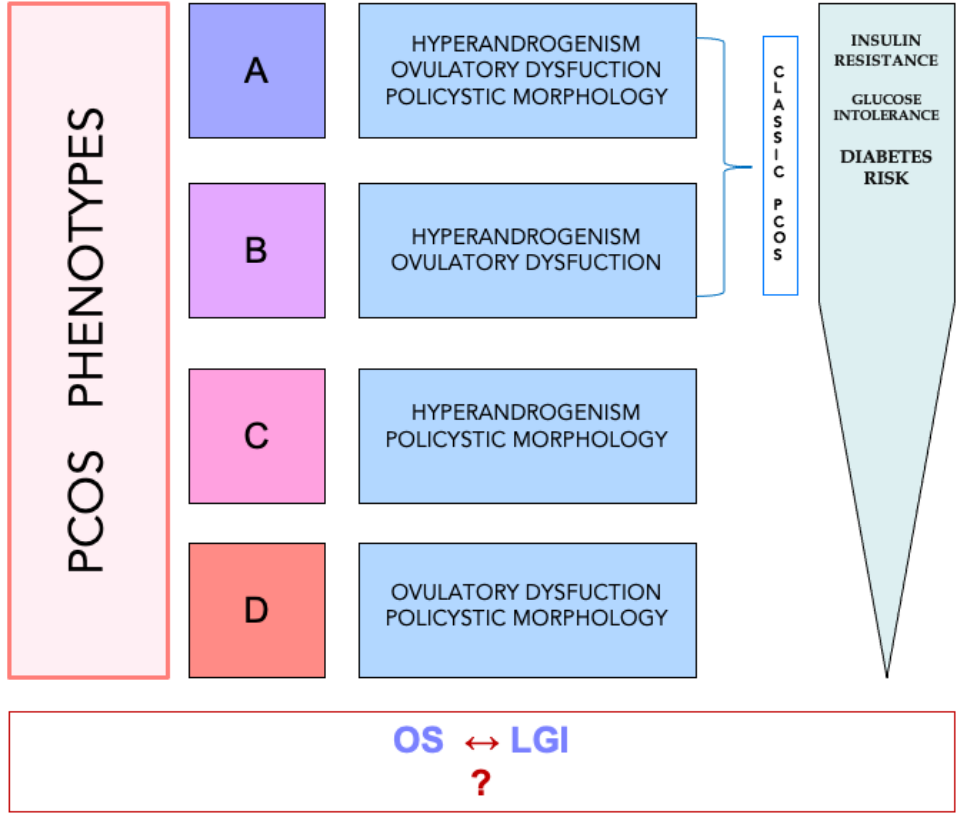
Figure 1. Diagram representing the classification of the different phenotypes of PCOS. While there is agreement on metabolic risk, which is higher in A-B phenotypes than C-D ones, clear correlation between phenotypes and parameters of oxidative stress (OS) and/or indexes of low-grade inflammation (LGI) is not defined (?).